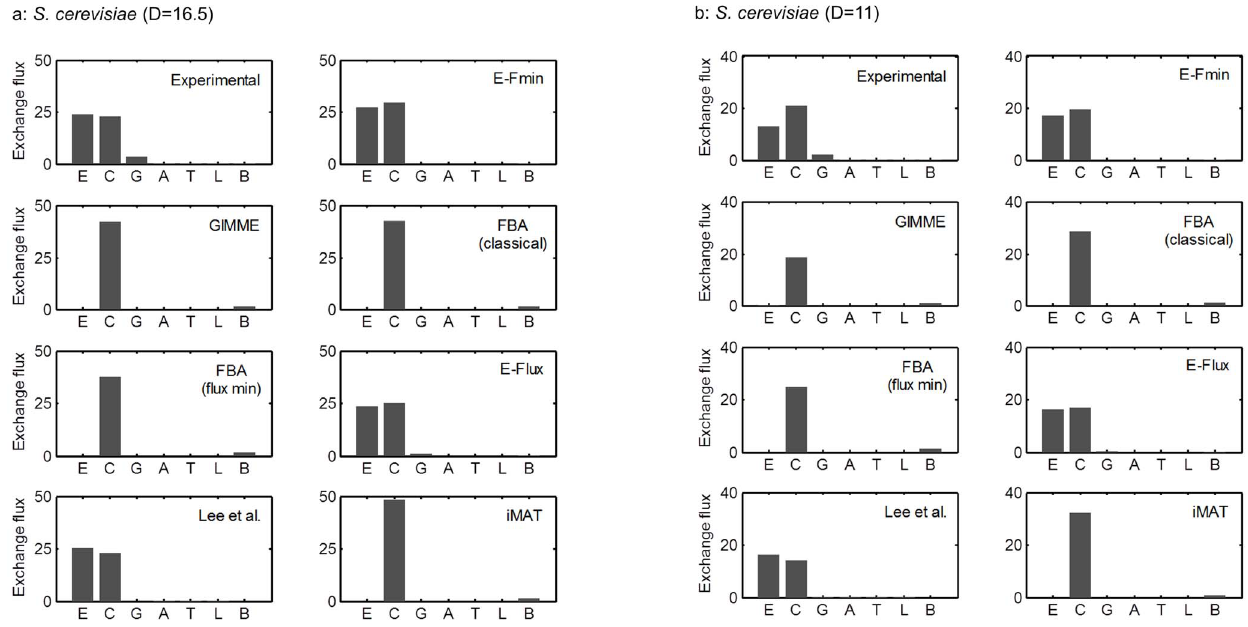
Figure 3. Exometabolome data of Saccharomycescerevisiae and model predictions. Bars represent experimental and predicted values of exchange fluxes when the glucose uptake was A ) 16.5 and B ) 11.0 mmol/(gDW ? h). Capital letters on the x -axis denote the production rates of extracellular metabolites, i.e., E: ethanol production, C: CO 2 production, G: glycerol production, A: acetate production, T: trehalose production, L: lactose production, and B: biomass production. GIMME, Gene Inactivity Moderated by Metabolism and Expression; FBA, flux balance analysis; iMAT, integrative metabolic analysis tool.